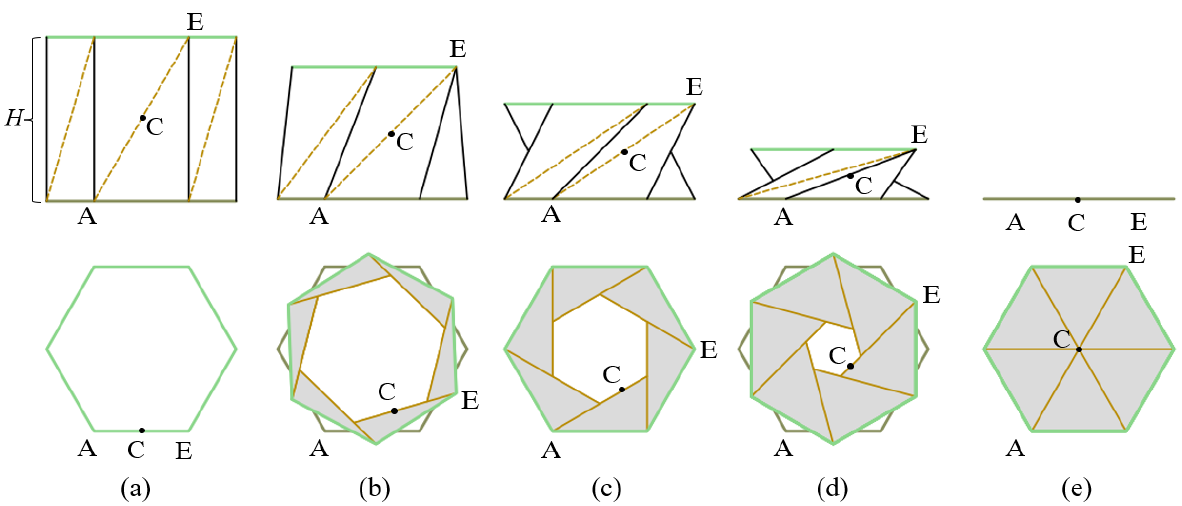
Figure 5. Kresling pattern folding process. ( n = 6) ( a ) Fully unfolded state. ( b – d ) Folding process. ( e ) Fully folded state. Line AE represents a diagonal, and C is the midpoint of the diagonal.